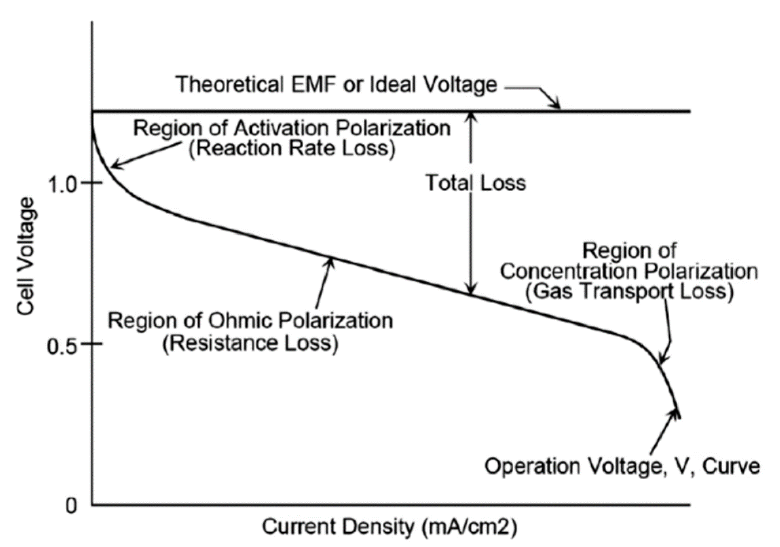
Figure 6. Polarisation curve of a PEMFC. Reproduced from [20] under the Creative Commons Li-